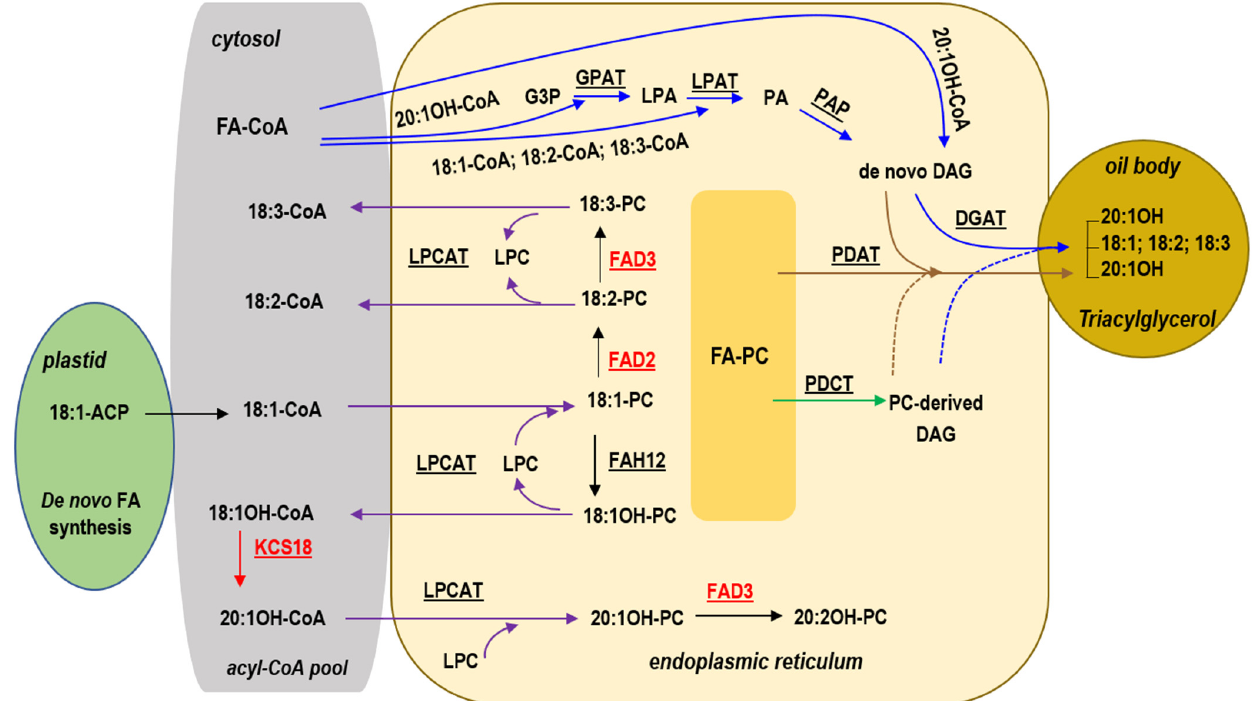
Figure 1. Simplified pathways for fatty acid and triacylglycerol synthesis in lesquerella seeds. Blue arrows indicate reactions involved in the Kennedy pathway. Purple arrows indicate reactions involved in acyl editing by LPCAT. Brown arrows indicate PDAT-mediated pathways. Green arrow indicates reactions involved in PC-derived DAG synthesis. Dotted lines indicate PC-derived DAG utilized by DGAT and PDAT. The red arrow indicates the elongation step by KCS18. Enzymes catalyzing these reactions are underlined. Red fonts are the targeted enzymes in this study. Fatty acid numerical symbols: 18:1, oleic acid; 18:1OH, ricinoleic acid; 20:1OH, lesquerolic acid; 20:2OH, auricolic acid; 18:2, linoleic acid; 18:3, linolenic acid. Abbreviations: CoA, co-enzyme A; PC, phosphatidylcholine; LPCAT, lysophosphatidylcholine acyltransferase; LPC, lysophosphatidylcholine; FAH12, ∆ 12 oleic acid hydroxylase; KCS18, 3-ketoacyl-CoA synthase 18; G3P, glycerol-3-phosphate; LPA, lysophosphatidic acid; PA, phosphatidic acid; DAG, diacylglycerol; GPAT, glycerol 3-phosphate acyltransferase; LPAT, lysophosphatidic acid acyltransferase; PAP, phosphatidic acid phosphatase; DGAT, diacylglycerol acyltransferase; PDAT, phospholipid:DAG acyltransferase; PDCT, PC:DAG cholinephosphotransferase; TAG,